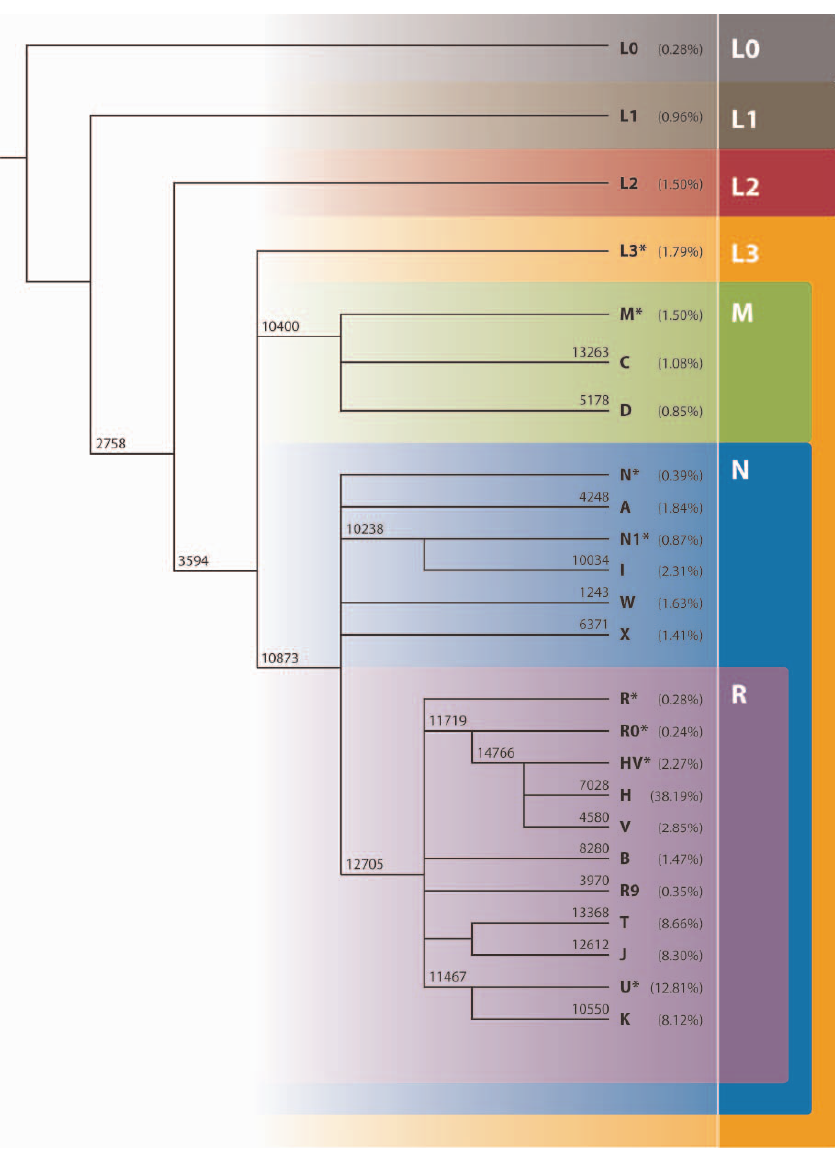
Figure 4. The Phylogeny of mtDNA Haplogroups Inferred from the Panel of 22 Coding-Region SNPs Used in the Genographic Project The coding-region mutations are shown on the branches. The frequencies of the haplogroups found among the Genographic participants are shown in brackets beside the Hgs assignments and correspond to Table 2. Note that the figure discriminates between haplogroups L0 and L1 while the coding- region SNPs used during genotyping do not distinguish the two and therefore they are labeled throughout the paper as L0/L1.